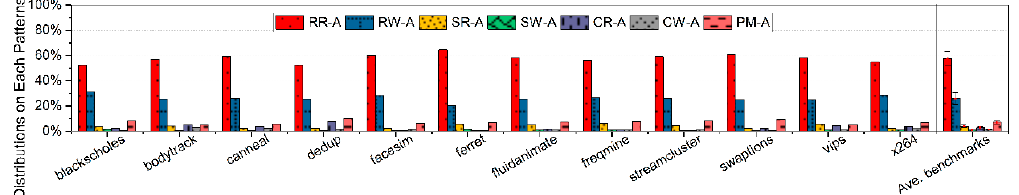
Figure 3. Access distributions on seven types of private cache accesses. All benchmarks are simulated to calculate distribution values by counted number in a pattern/all accesses.